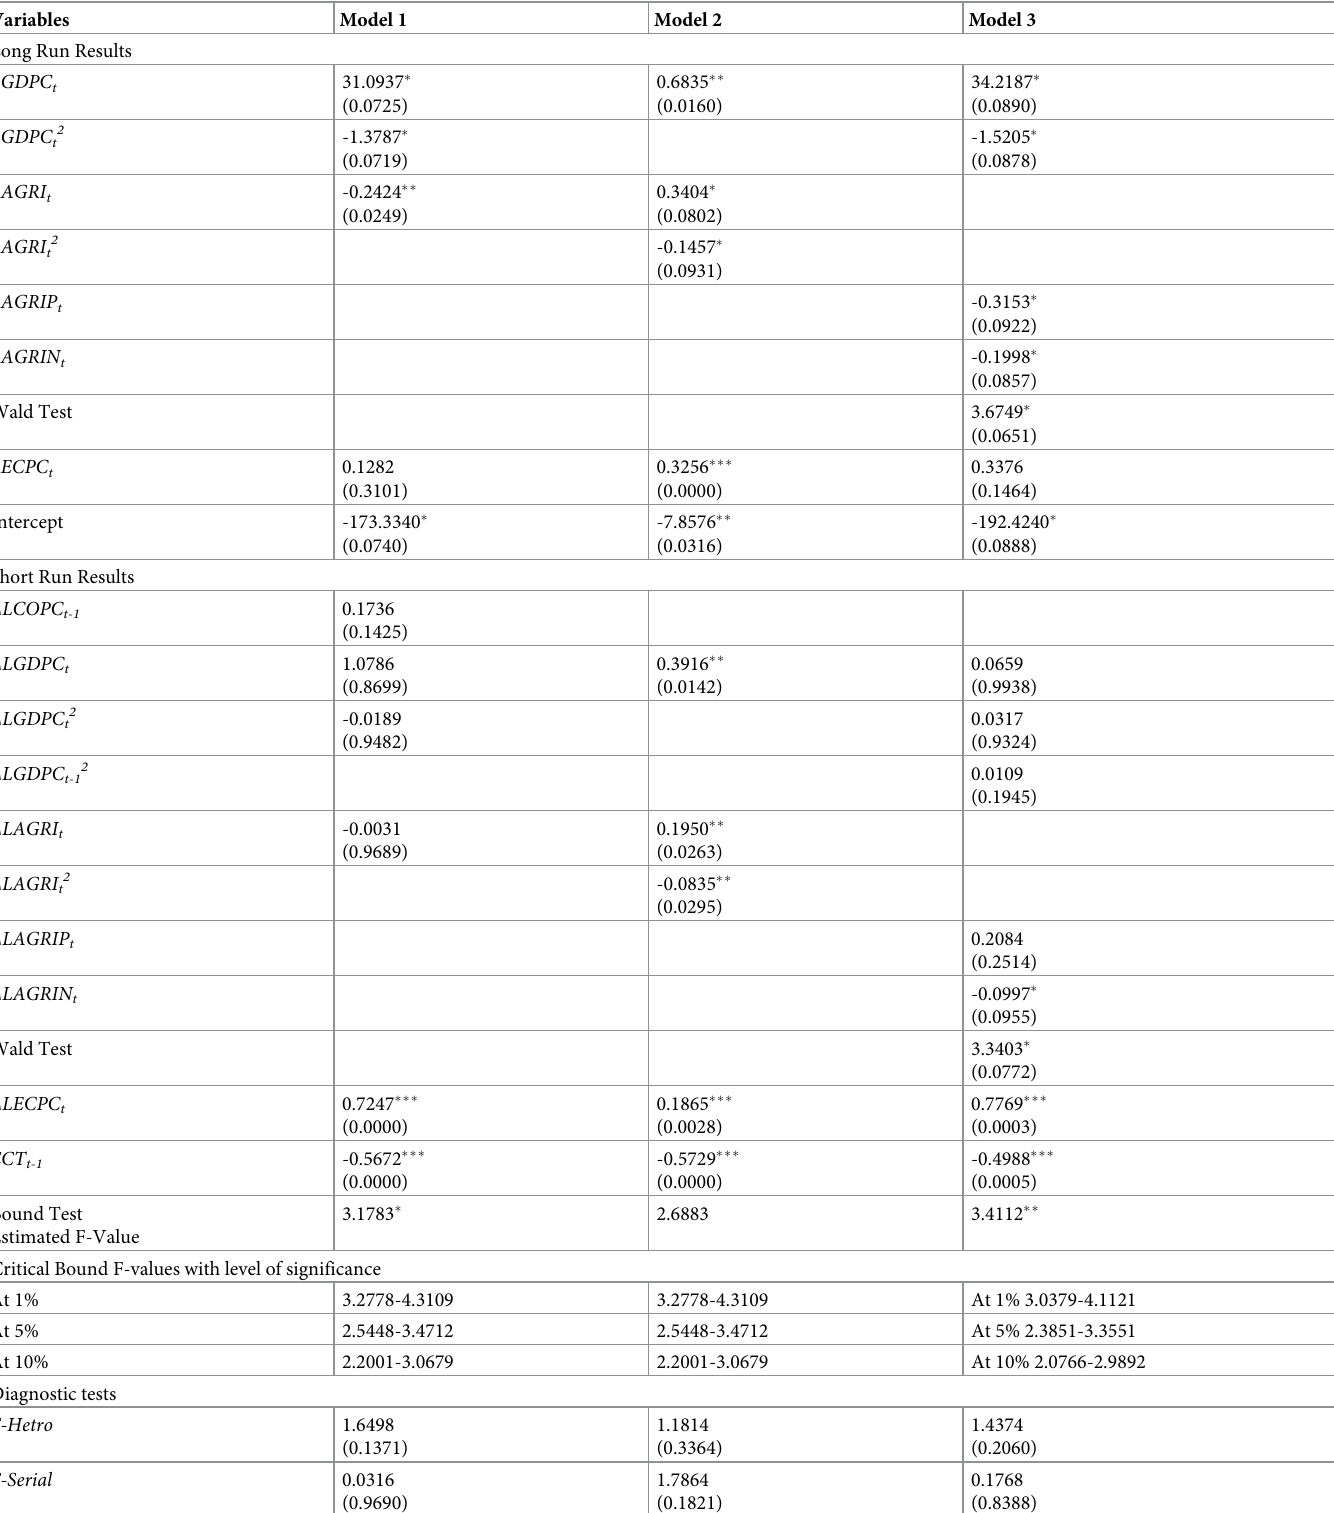
Table 3. Estimates from linear and nonlinear ARDL